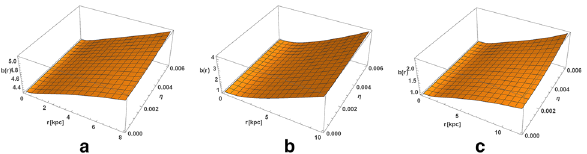
byusing ρ 0 =0.004 kpc − 2 , r 0 = 2 kpc for a NFWprofile: r th = 1 . 7 kpc b Pseudo-Isothermal profile : r th = 1 kpc (c)URC profile : r th = 1 . 1 kpc